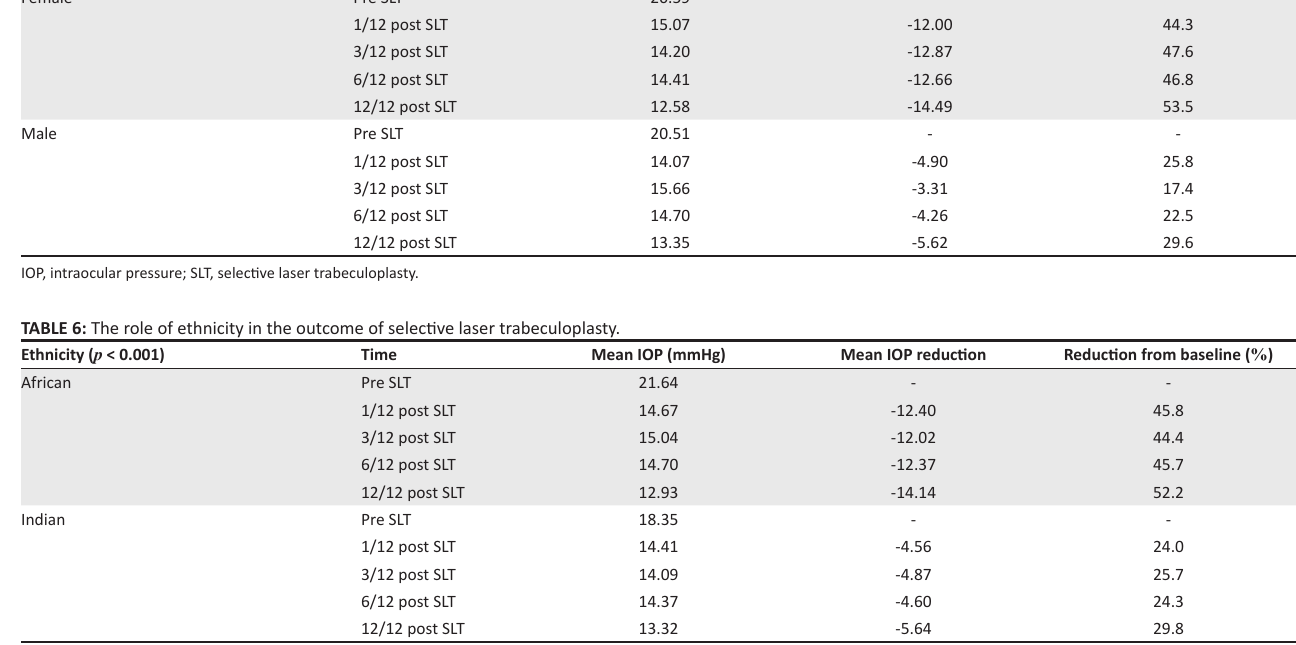
TABLE 5: The role of gender in the outcome of selective laser trabeculoplasty. Gender ( p < 0.001)